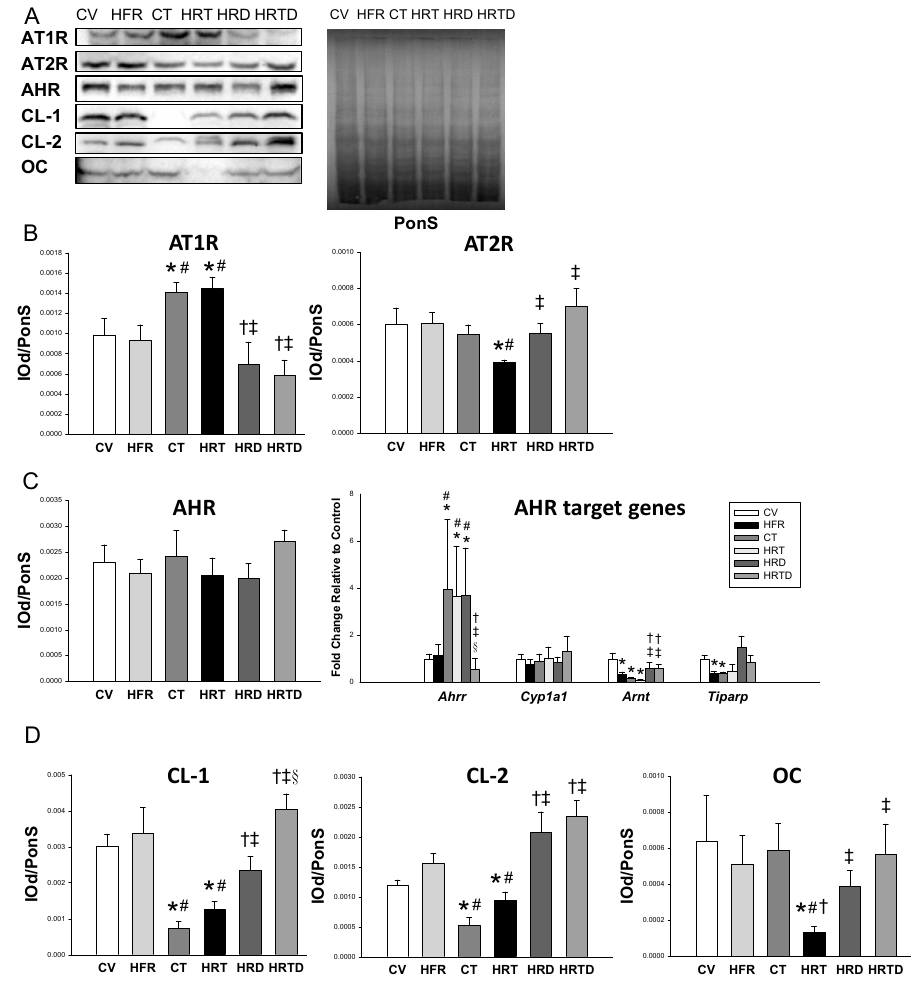
Figure 3. ( A ) Representative Western blots and Ponceau S red (PonS) staining showing angiotensin II type 1 receptor (AT1R; 43 kDa), angiotensin II type 2 receptor (AT2R; 50 kDa), aryl hydrocarbon receptor (AHR; 96 kDa), claudin-1 (CL-1, 23kDa), claudin-2 (CL-2, 25kDa), and occludin (OC; 65kDa) in offspring at 12 weeks of age. ( B ) Relative abundance of AT1R and AT2R in the kidneys. ( C ) The protein level of AHR and mRNA expression of AHR target genes, including Ahrr, Cyp1a1, Arnt, and Tiparp were analyzed by qPCR. ( D ) The relative abundance of CL-1, CL-2, and OC in the ileum. CV = control rat received regular diet and vehicle; HFR = rats received high-fructose diet; CT = rats received regular diet and TCDD exposure; HRT = rats received high-fructose diet and TCDD exposure; HRD = rats received high-fructose diet and DMB treatment; HRDT = rats received high-fructose diet, TCDD exposure, and DMB treatment. Data were analyzed by one-way ANOVA with post hoc Tukey’s test. n = 8 /